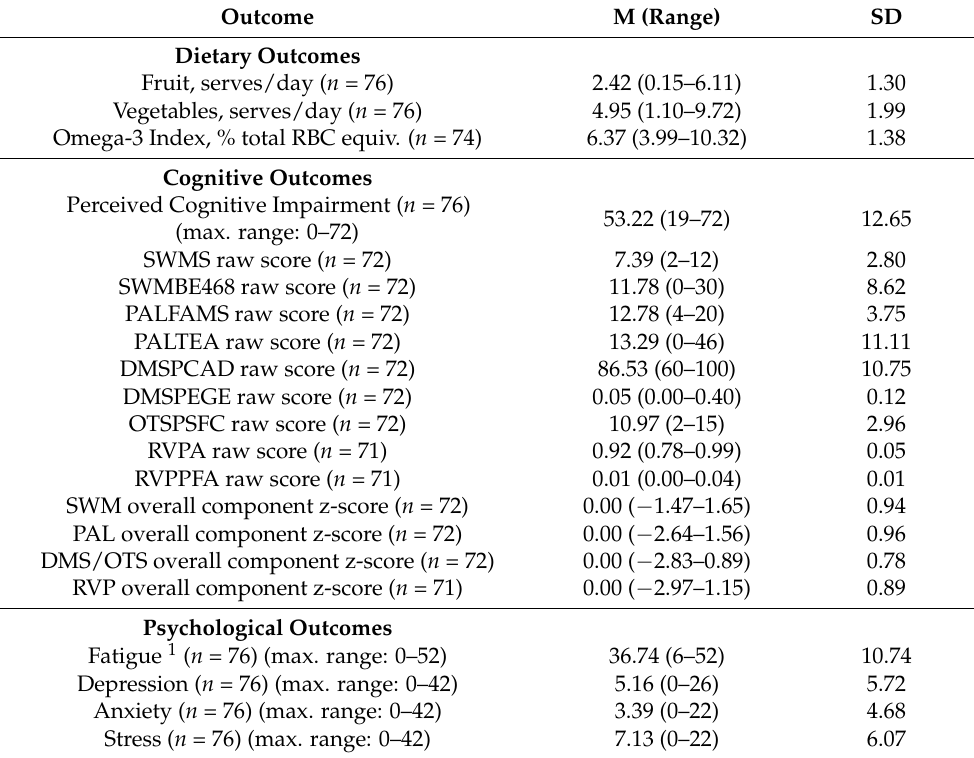
Table 3. Outcome measures of final sample ( n =